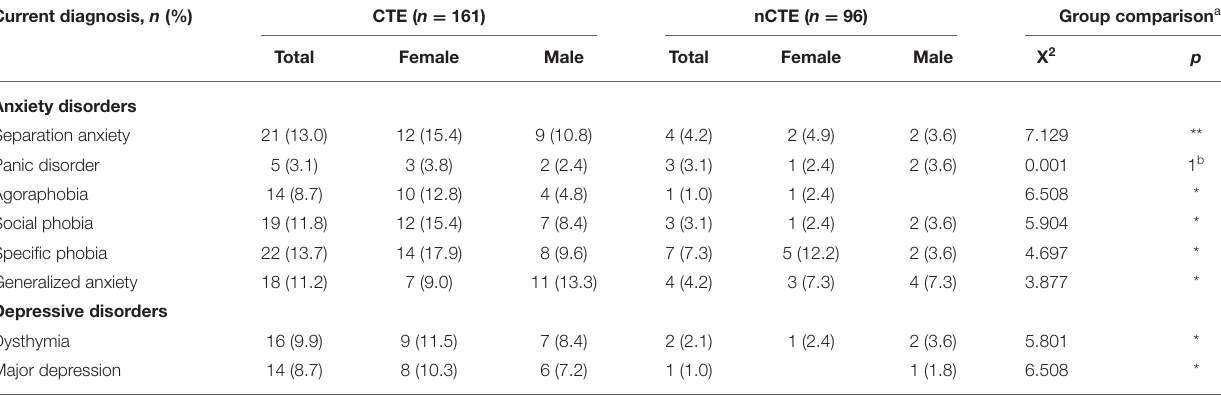
TABLE 3 | Current internalizing mental health disorders (diagnosis) and group comparisons. Current diagnosis, n (%) CTE ( n = 161) Group comparison a